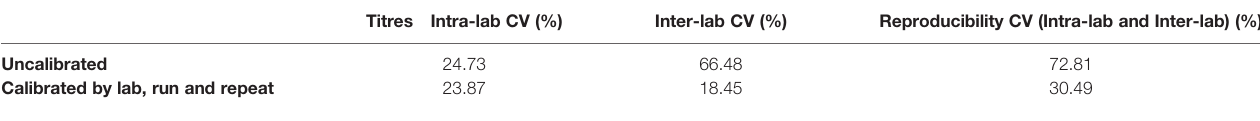
TABLE 5 | Intra-lab CV, Inter-lab CV and Reproducibility CV for uncalibrated titres and calibrated titres by lab, run and